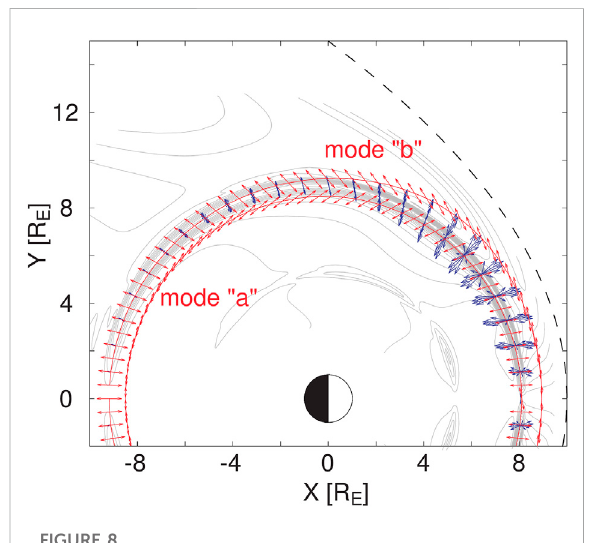
FIGURE 8 Reproduction of Figure 7 of Degeling et al. (2010). Grey contours: equatorial amplitude of E α showing the FLR, taken 3 h afterthestartoftherun,bywhichtimethesolutionapproximatesa normal mode; bluevectors: equatorial electric fi eldalong the FLR peak, at various phases; red vectors: equatorial electric fi eld polarizationofthegeneralizedSAWeigenfunctions(modes “ a ” and “ b ” ) along their resonance surfaces (solid red lines); dashed line: the magnetopause